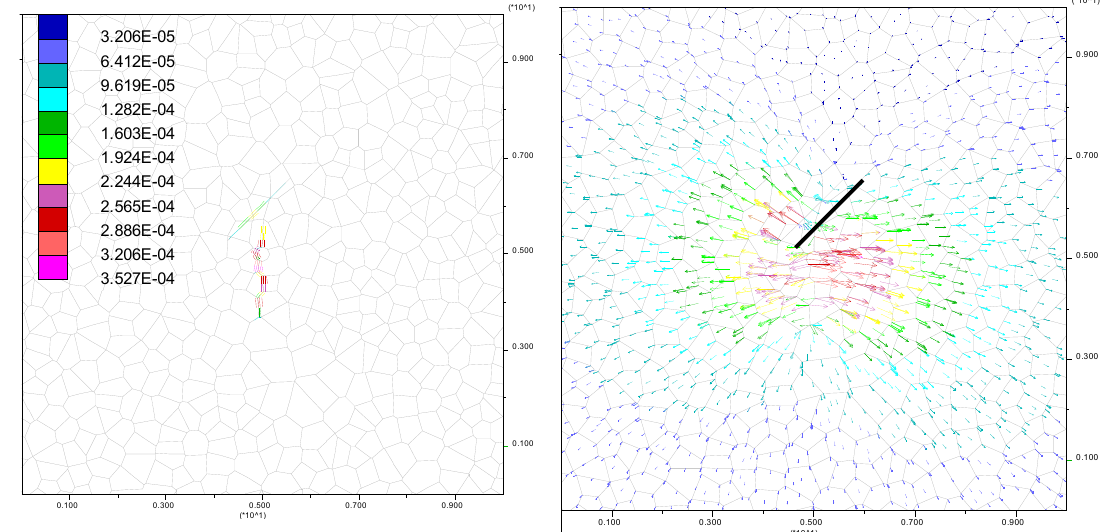
Figure 4. Opening mode in numerical modeling with an incidence angle of 45 degrees under low differential stresses of 1 MPa